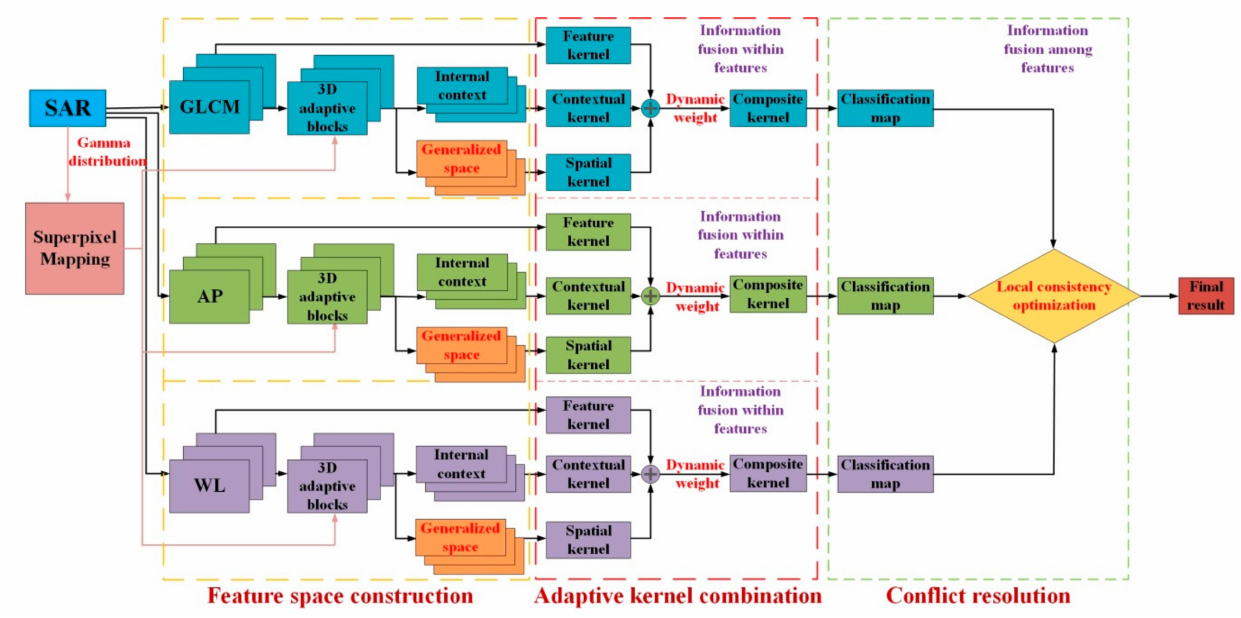
Figure 1. Framework of the proposed